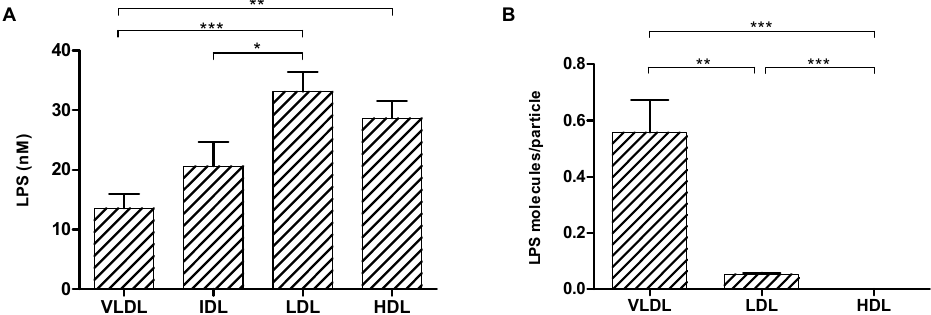
Figure 1. ( A ) Mean concentration (nM) of LPS in VLDL, IDL, LDL and HDL fractions in the study group. ( B ) Mean LPS/particle ratio in VLDL, LDL and HDL. * p < 0.05, ** p < 0.01 and *** p < 0.001.